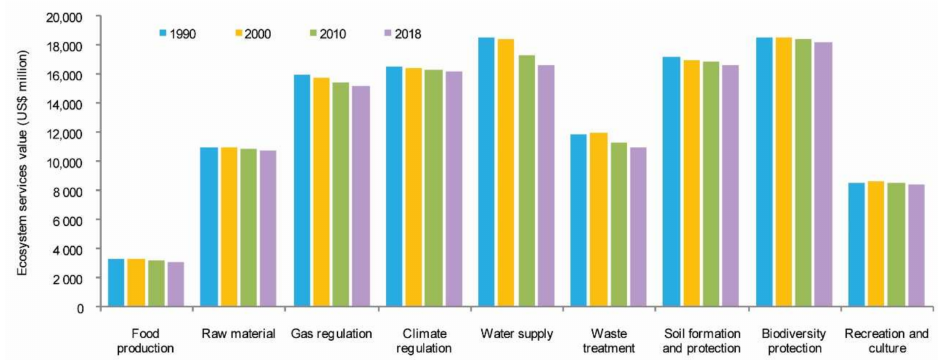
Figure 4. Value of individual ecosystem services of Guangdong province from 1990 to